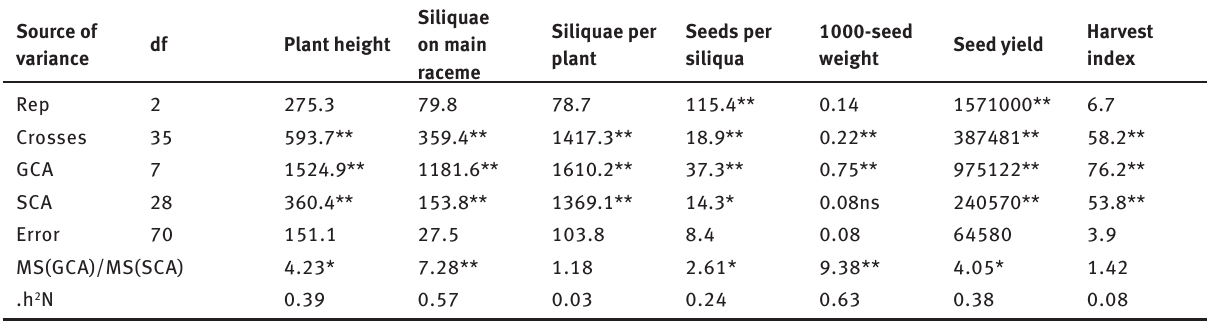
Table 1: Analysis of variance of plant height and yield components for oilseed rape genotypes based on Griffing’s method two with mixed-B